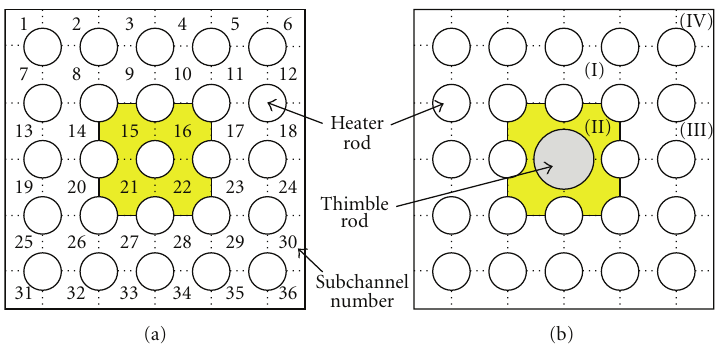
Figure 1: Cross-sectional view of PSBT 5 × 5 test bundles.